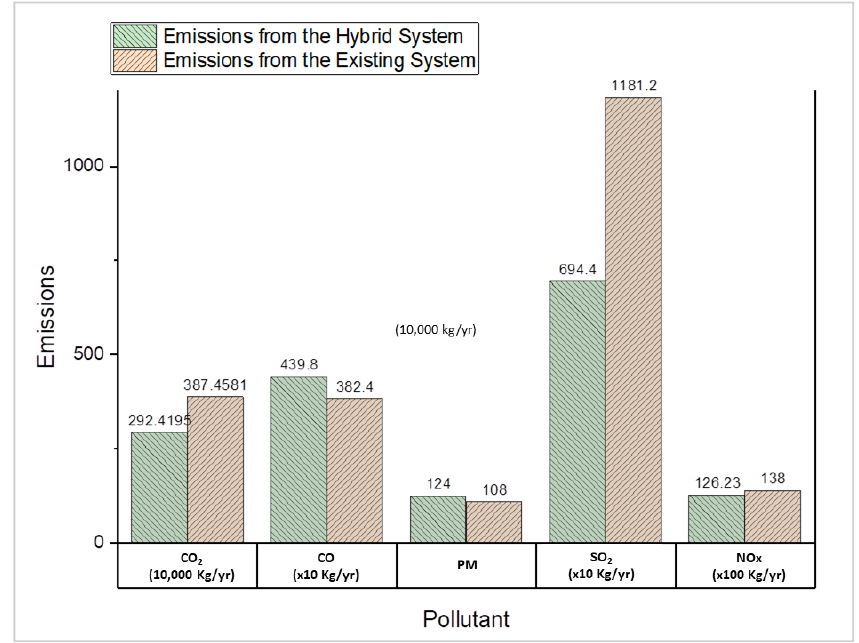
Figure 16. Pollutant-wise comparison of emissions from the proposed hybrid energy system and the existing power system.